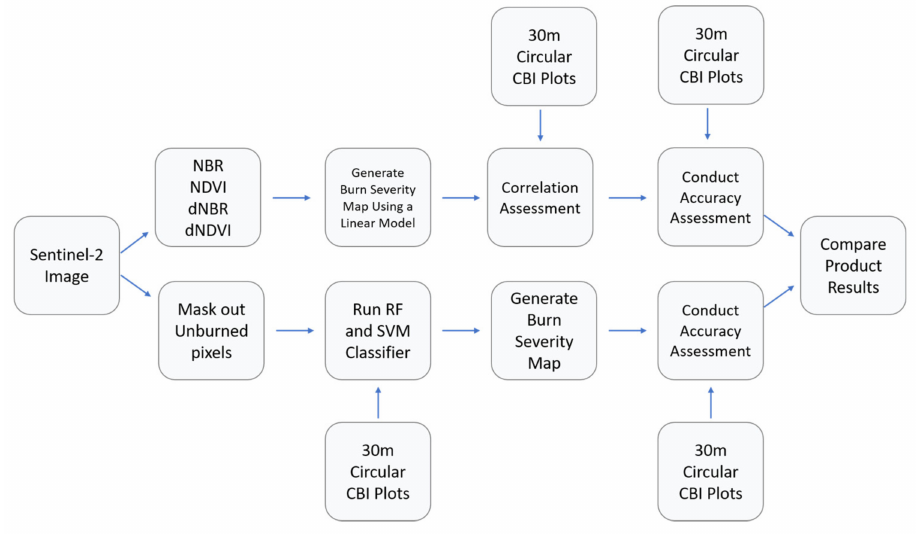
Figure 3. Image processing workflow for burn severity mapping and accuracy